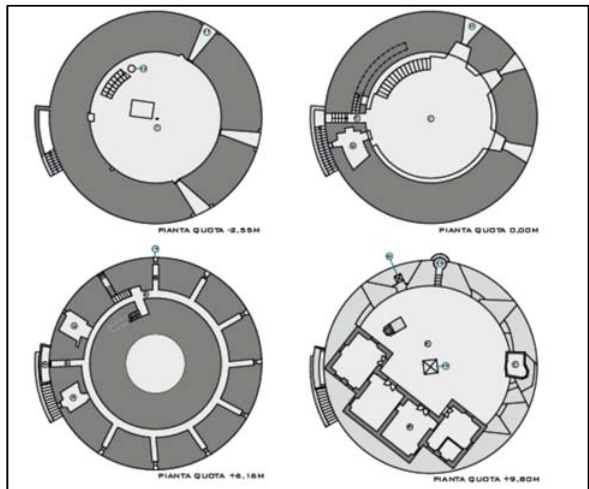
Figure 2. The Gran Torre of Oristano – plans